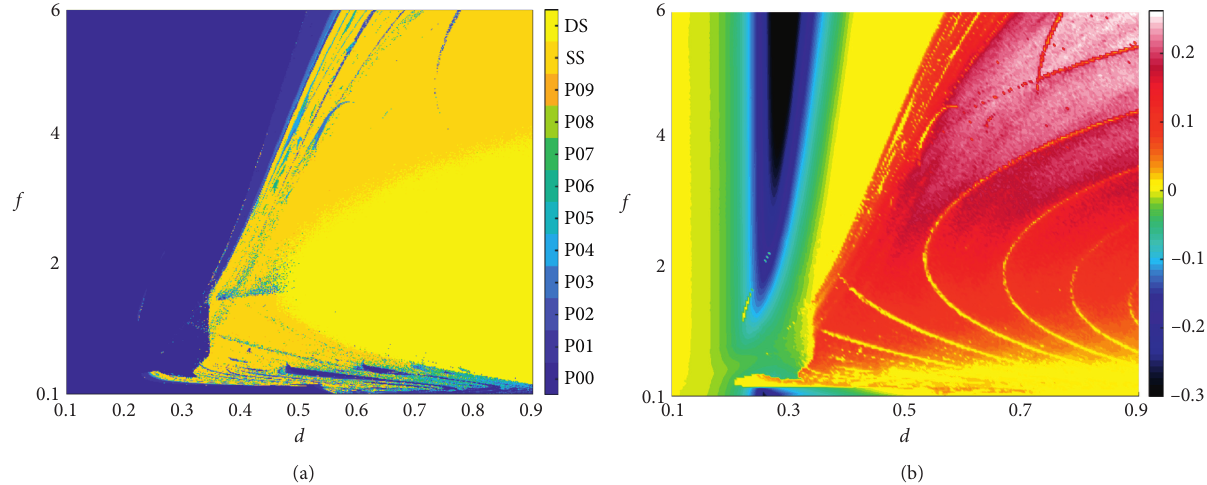
Figure 3: 2D dynamical behaviors in the d – f parameter plane. (a) Bifurcation plots depicted by the periodicities of the state variable x . (b) Dynamical maps described by the largest Lyapunov